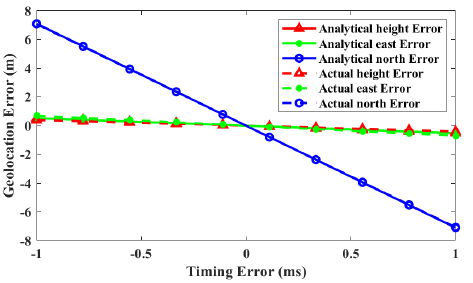
Figure 4. The influence of the timing error of the master satellite on the three-dimensional geoloca- tion